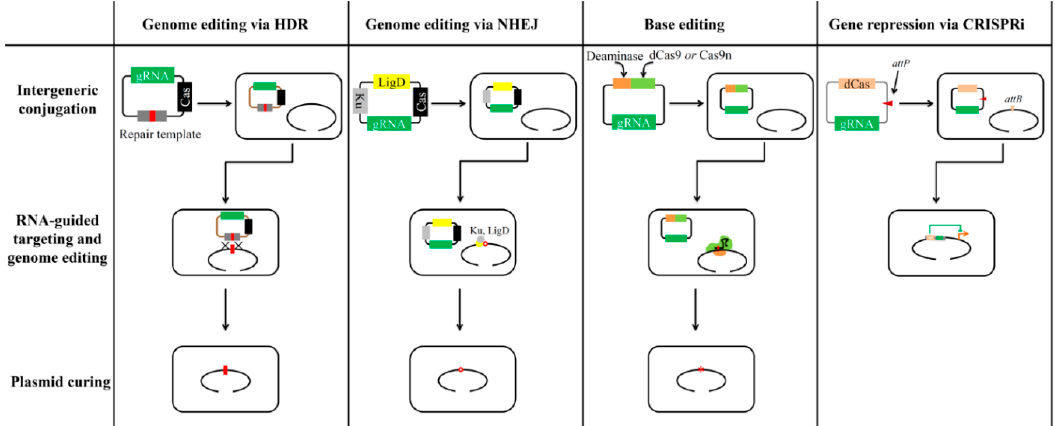
Figure 2. A brief illustration of the CRISPR/Cas system-based technologies for genome editing in Streptomyces . Column 1: Genome editing by homology-directed repair (HDR). An editing plasmid with the expression cassettes of the Cas endonuclease and a small guide RNA (gRNA), and containing homologous repair template is introduced into Streptomyces by intergeneric conjugation. The Cas nuclease cleaves the target site on the genome with the help of gRNA, resulting in double-strand break (DSB). The DSB is repaired by HDR in the presence of homologous repair template. Then, specific mutations, such as deletions, insertions, and point mutations, are introduced. After plasmid curing, the edited strain could be subject to next round genome editing. Column 2: Genome editing